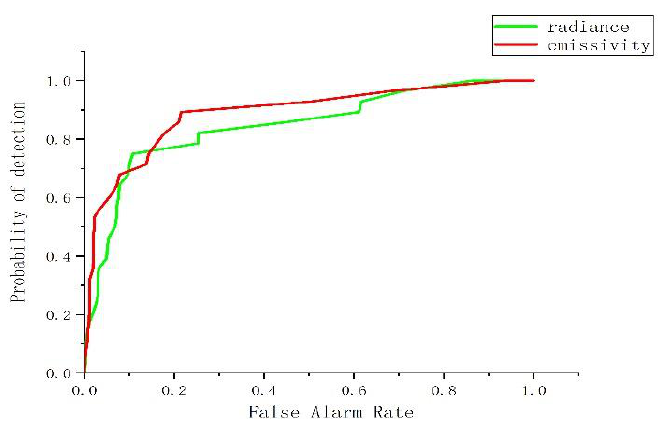
Figure 22. ROC curves of the metal plates data set.